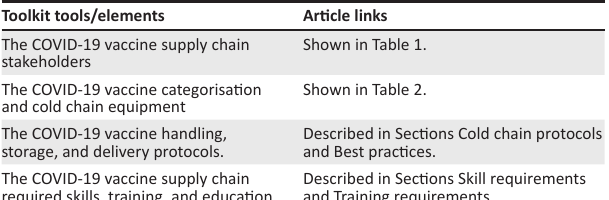
TABLE 4: Toolkit